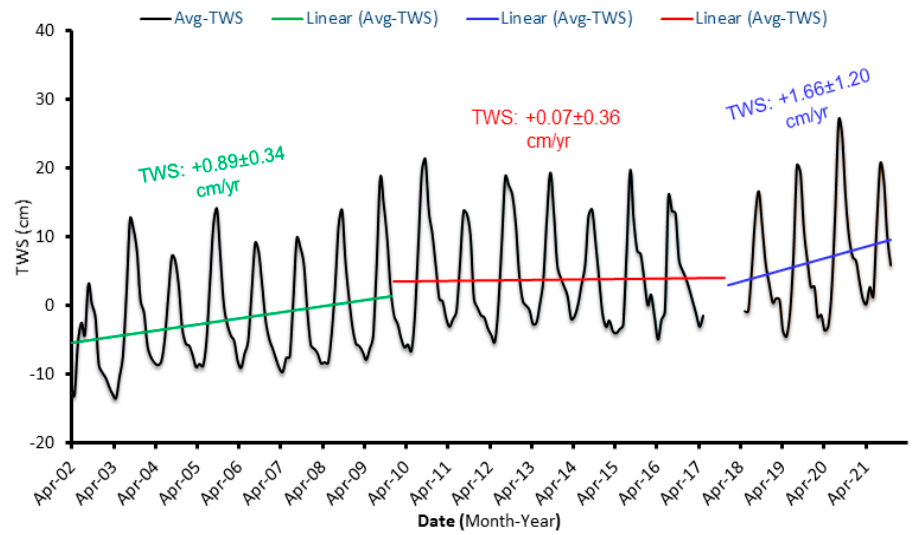
Figure 4. Monthly time series of the Avg-TWS over the study area during the three periods.